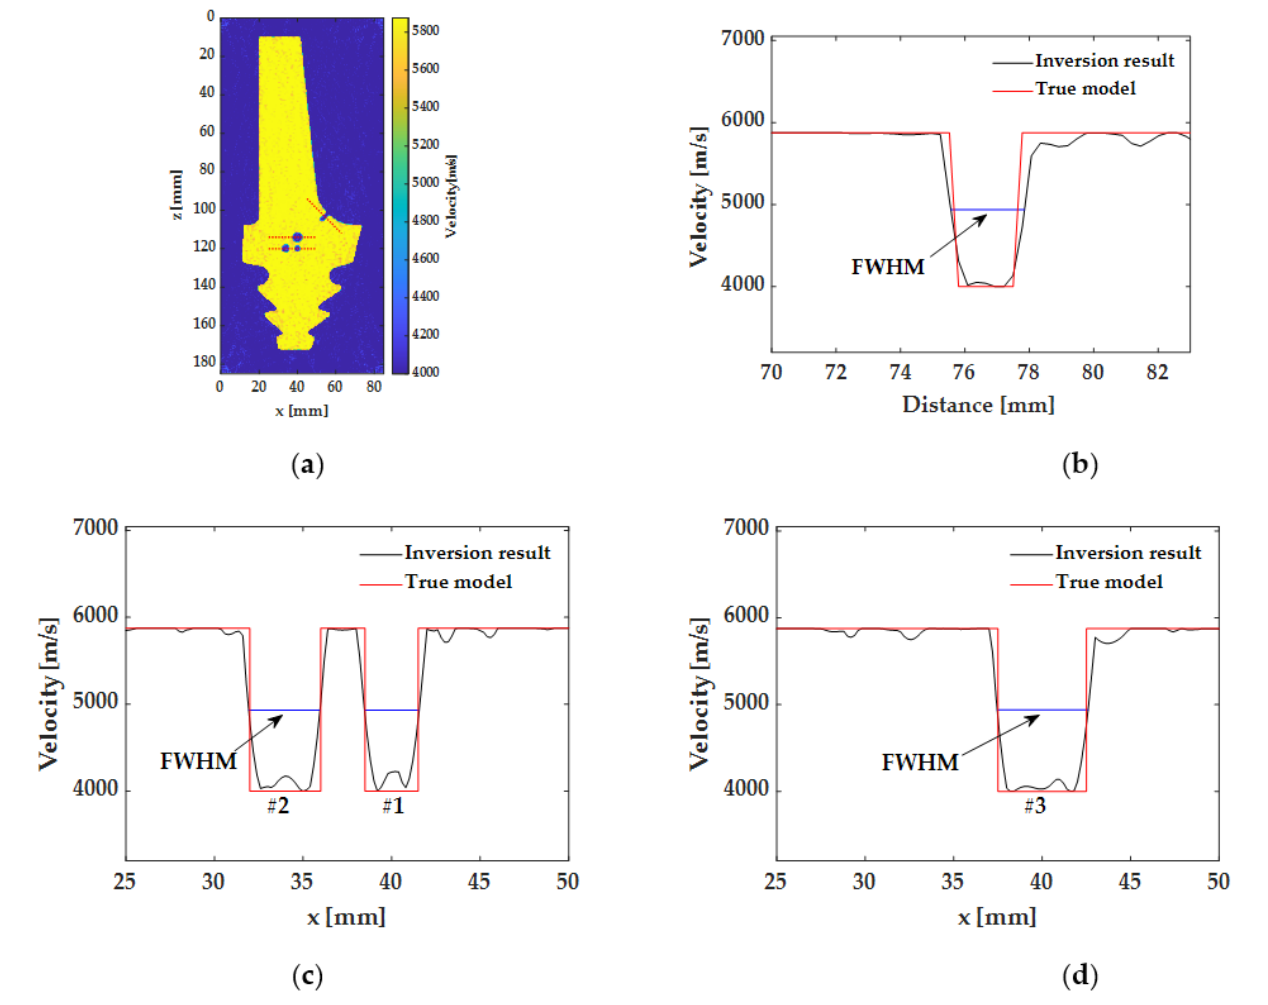
Figure 15. ( a ) FWI tomograph of three circular holes and a notch defect. Cross section ( b ) through the incline notch along the width direction, ( c ) through #1 and #2 defects along the horizontal direction and ( d ) through #3 defect along the horizontal direction. The positions are depicted in ( a ) with red dashed lines.